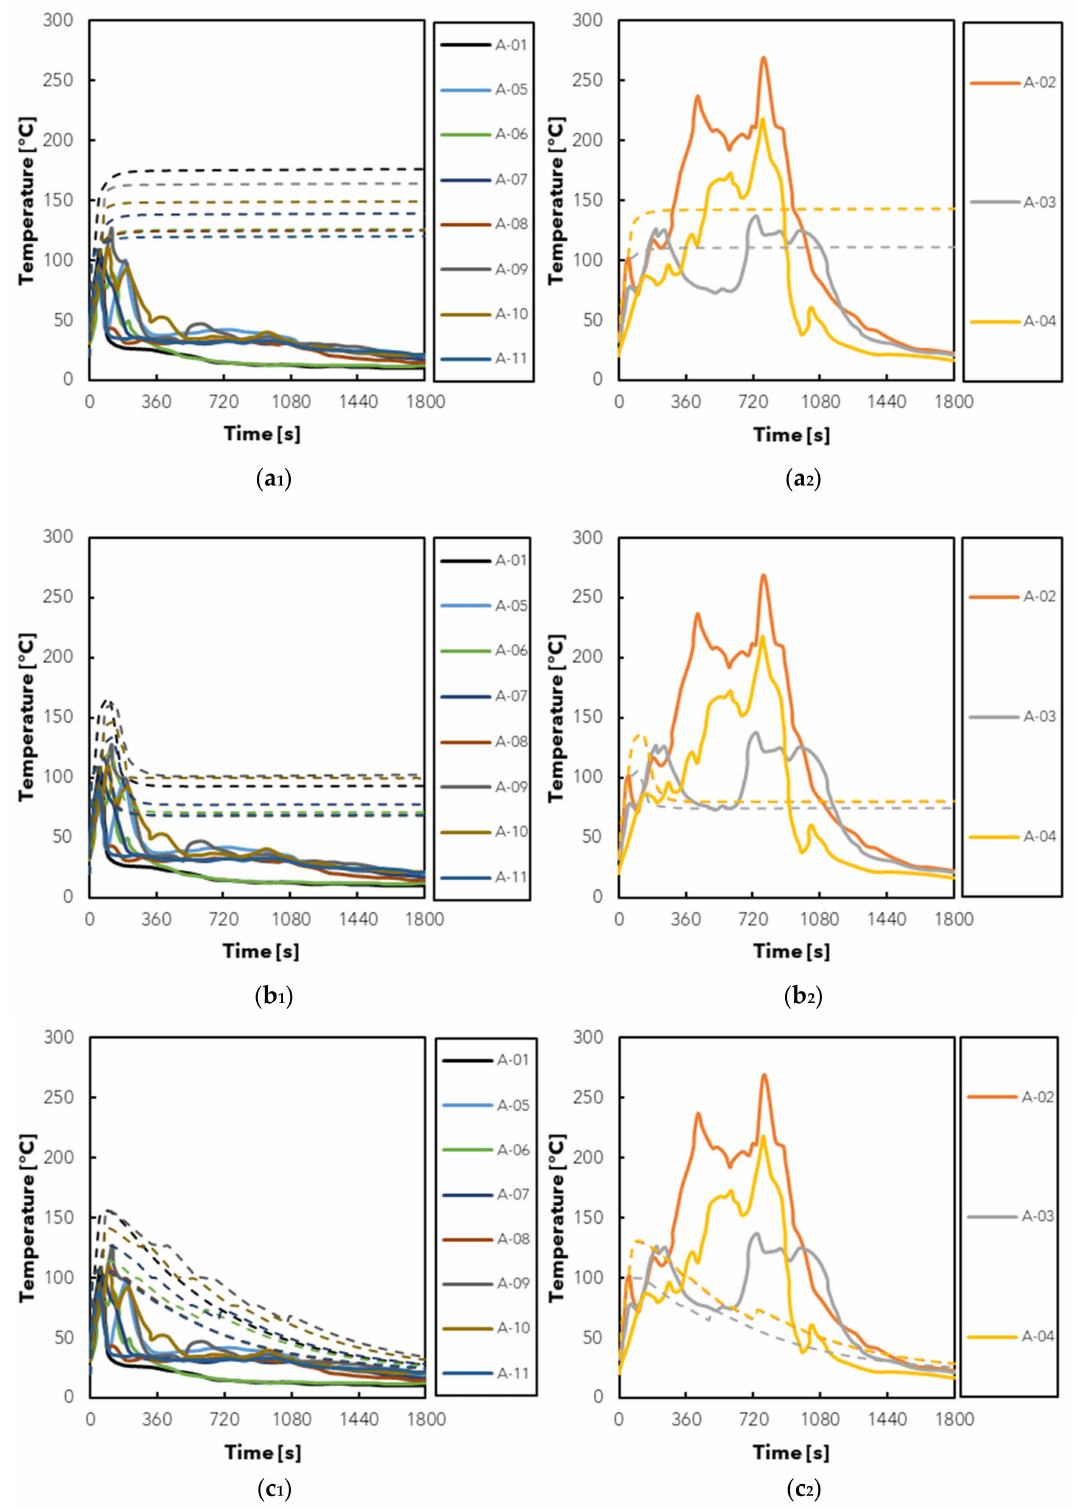
Figure 11. Comparison of thermocouple data (75 mm below ceiling) to ULT (estimated in B-RISK model) for three suppression assumptions: ( a 1 , a 2 ) sprinkler-controlled HRR; ( b 1 , b 2 ) Nystedt model; and ( c 1 , c 2 ) Evans model. Solid lines indicate thermocouple data and dashed lines indicate model estimations. Subscript 1 denotes tests where rapid temperature decay was observed following system activation and subscript 2 where rapid temperature decay was not observed after